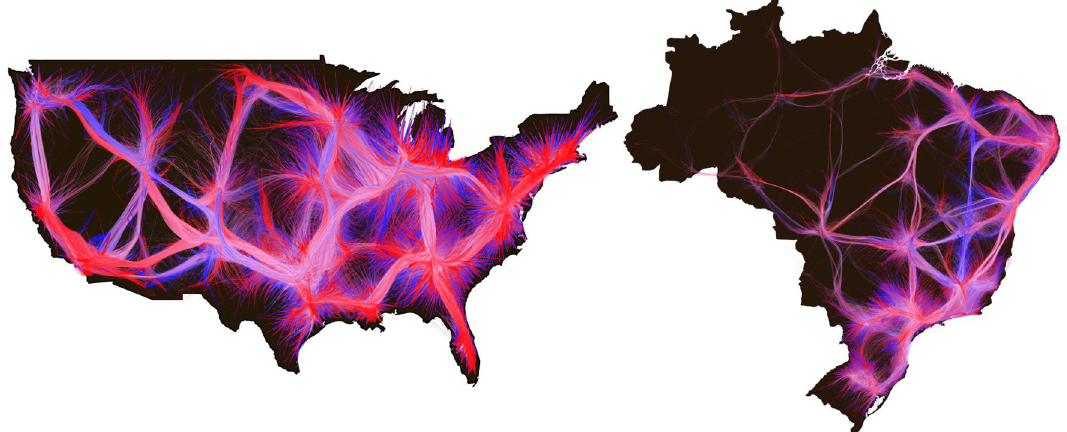
Figure 1. Visualization of the commuting networks among US counties (left) and Brazilian (right) municipalities. In this representation, nodes are urban areas and links represent the flow of commuters among them. Edge widths are associated with the flow intensity and colors refer to flow direction (bluish tones indicate outgoing links while reddish indicate incoming connections). This figure has been made using matplotlib 35 and geopandas 36 , we have further aggregated links based on their spatial proximity using a kernel-based edge the role of these networks on urban